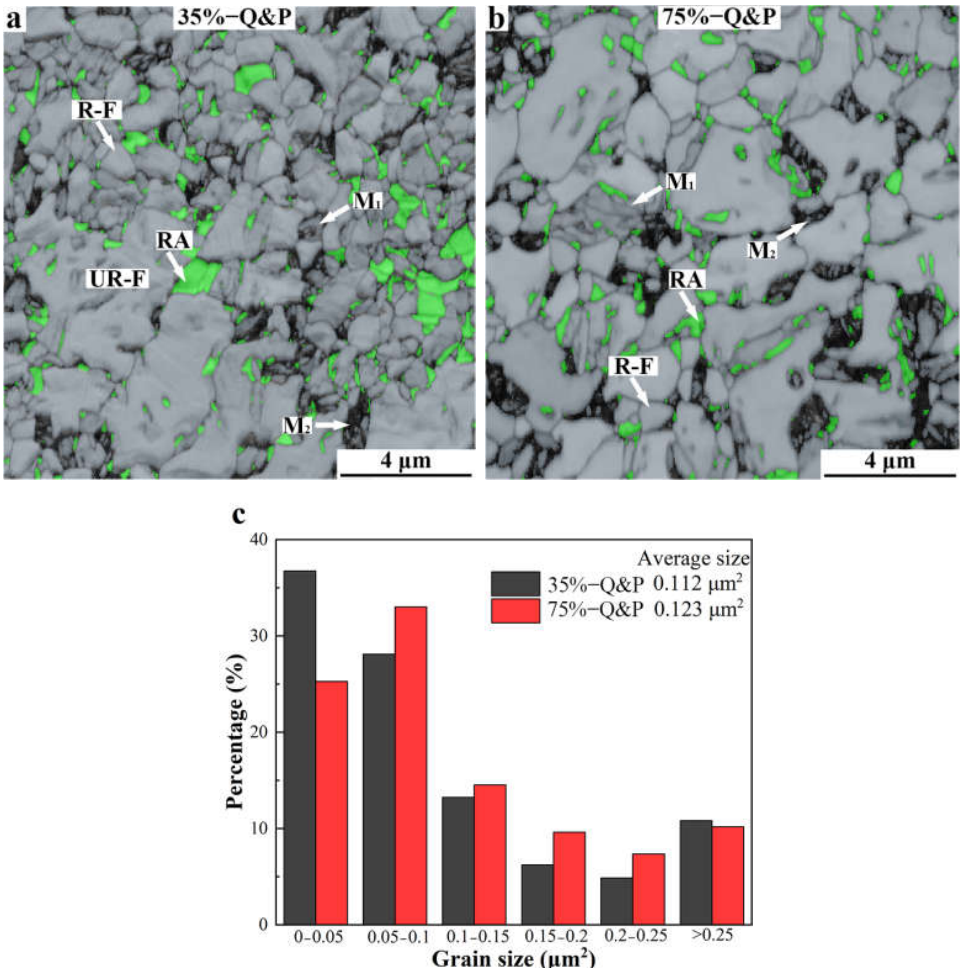
Figure 4. The image quality micrographs of ( a ) 35%−Q&P sample and ( b ) 75%−Q&P sample ana- lyzed by EBSD, ( c ) grain size distribution of retained austenite in 35%−Q&P sample and 75%−Q&P sample.